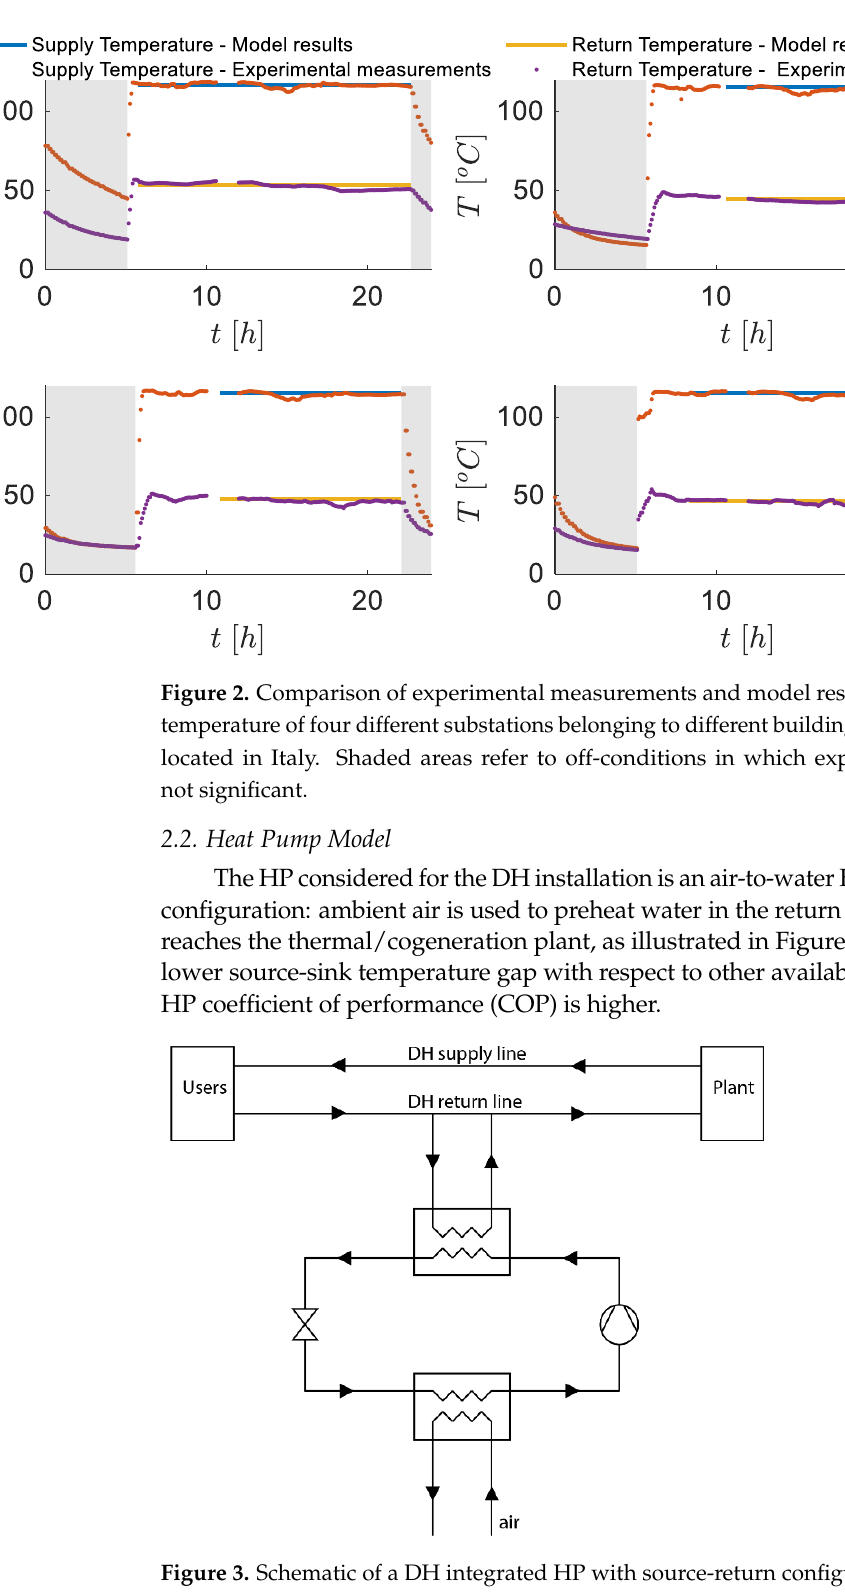
Figure 3. Schematic of a DH integrated HP with source-return configuration.